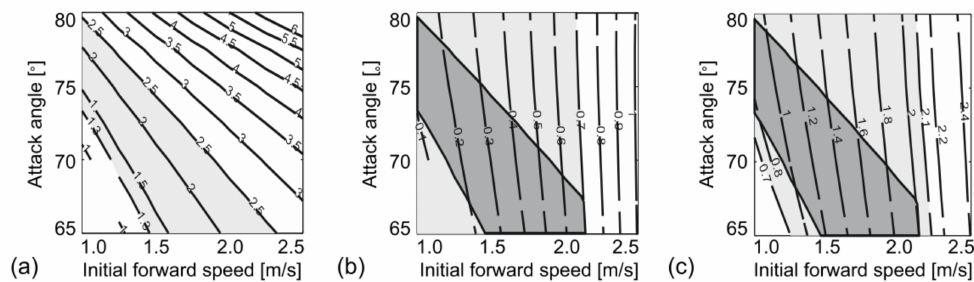
Figure 12. ( a ) Pacing rate, ( b ) DLF 1 , and ( c ) average forward speed of a pedestrian resulting from different combinations of the initial conditions in the IPRFM ( l + r = 1.037 m, r = 0.3 m). Refer to the text for explanation of the